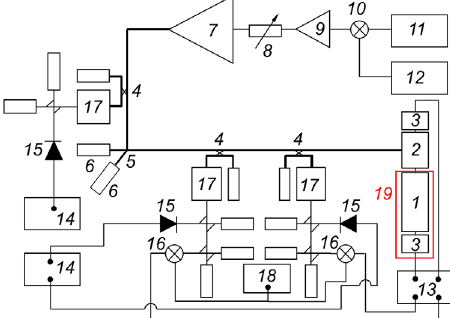
FIG. 4. Schematic diagram of the experimental setup: (1) Cryo- Cu-SLAC-#2; (2) TM 01 mode launcher; (3) current monitors for field emission currents; (4) high power directional couplers; (5) waveguide 3 dB hybrid; (6) high power loads; (7) SLAC XL-5 X-band klystron; (8) variable attenuator; (9) booster traveling wave tube; (10) mixer for klystron signal shaping; (11) signal generator; (12) arbitrary function generator; (13) fast digitizer; (14) peak power meter; (15) probes of peak power meter; (16) mixer for data acquisition; (17) low pass filters; (18) signal generator for data acquisition; (19) cryostat envelope. Not numbered: cross guide directional couplers that couple signal between low pass filter (17) and probes (15) and (16) and low power rf loads which are connected to high power directional couplers (4) and cross guide directional couplers.